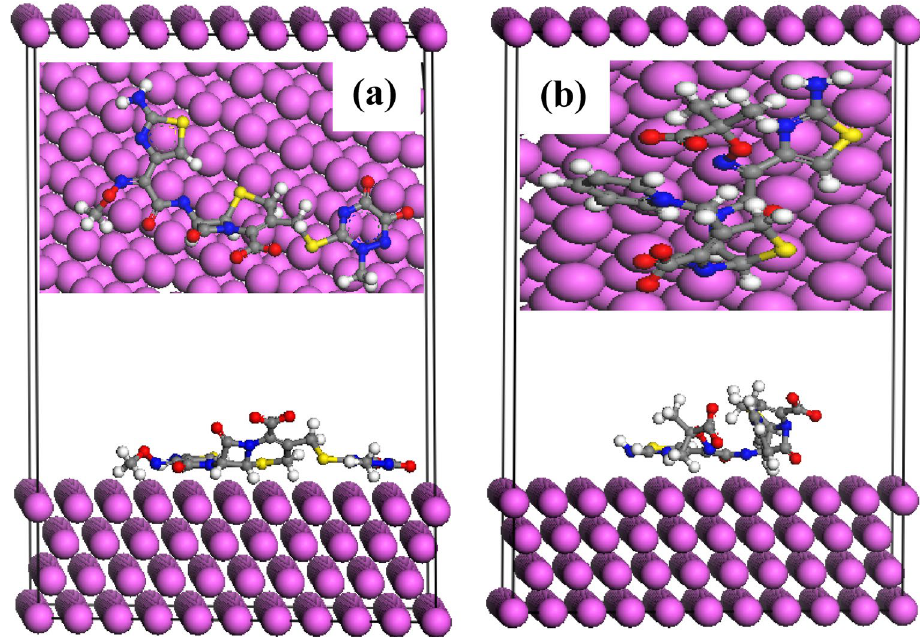
Figure 15. The lowest-energy geometry of the adsorbed ( a ) Cefx and ( b ) Cefz on the Al (111) surface as obtained from MC simulation.